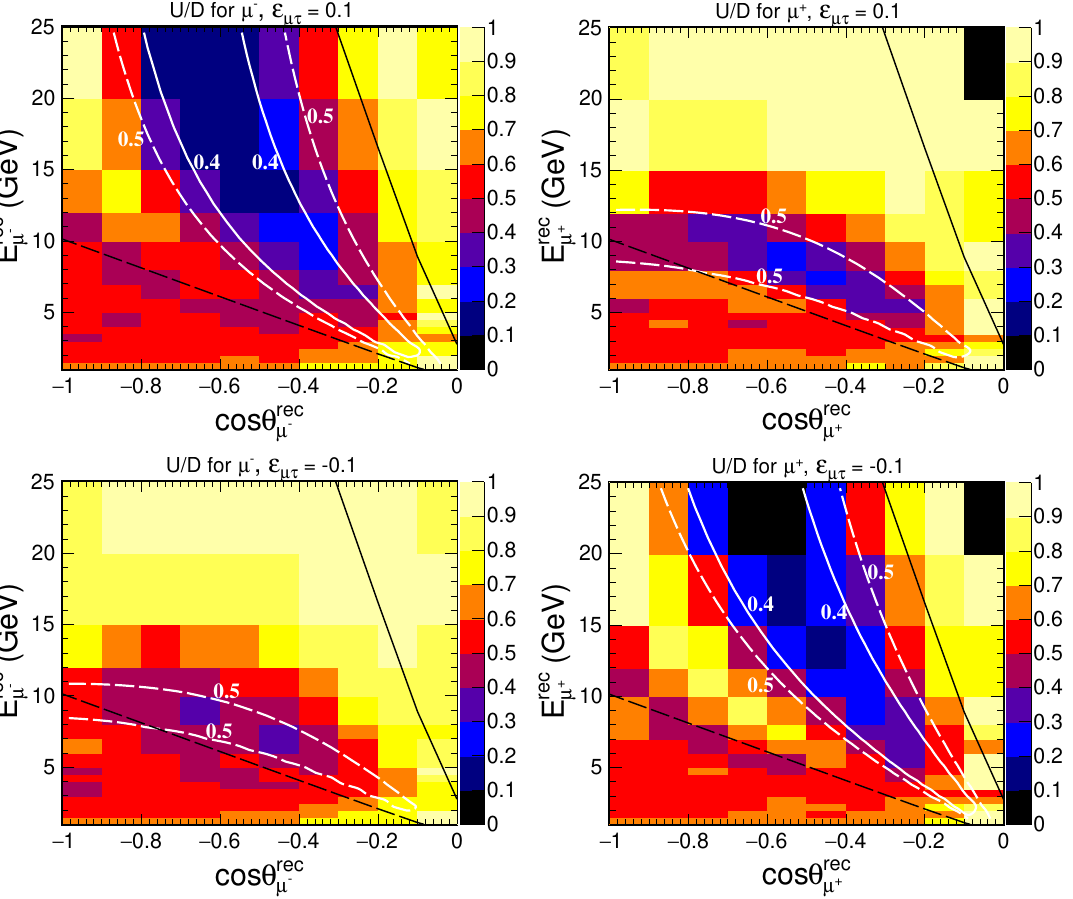
, cos θ rec ) plane with non-zero | ε (+0.1 in µτ | µ µ [ L rec ] = 2 . 2 /E rec 10 µ µ